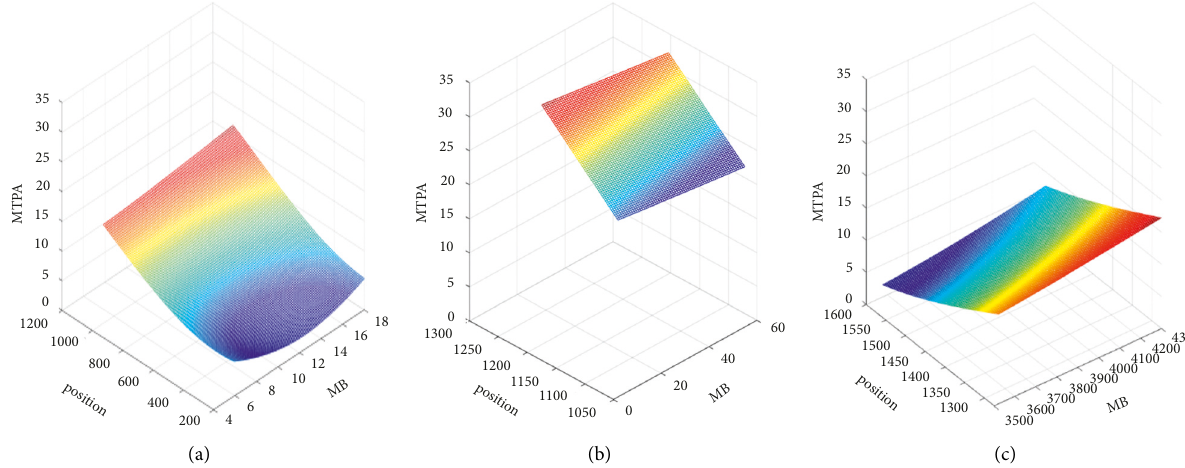
Figure 12: The effect of measured brightness and position on MTPA in stages 3–5. (a) Stage 3. (b) Stage 4. (c) Stage